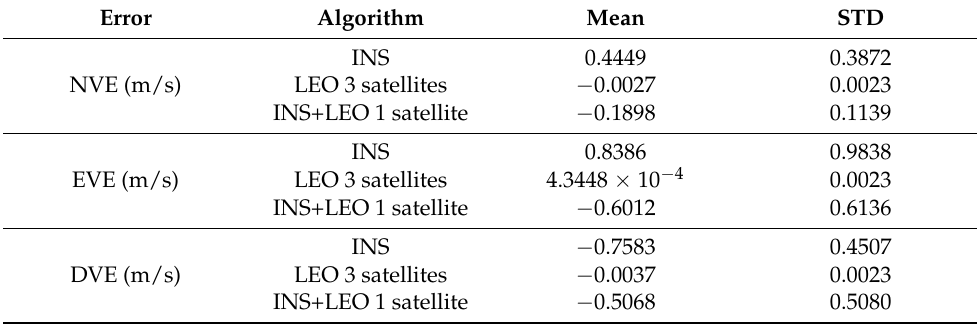
Table 3. Velocity error statistics.